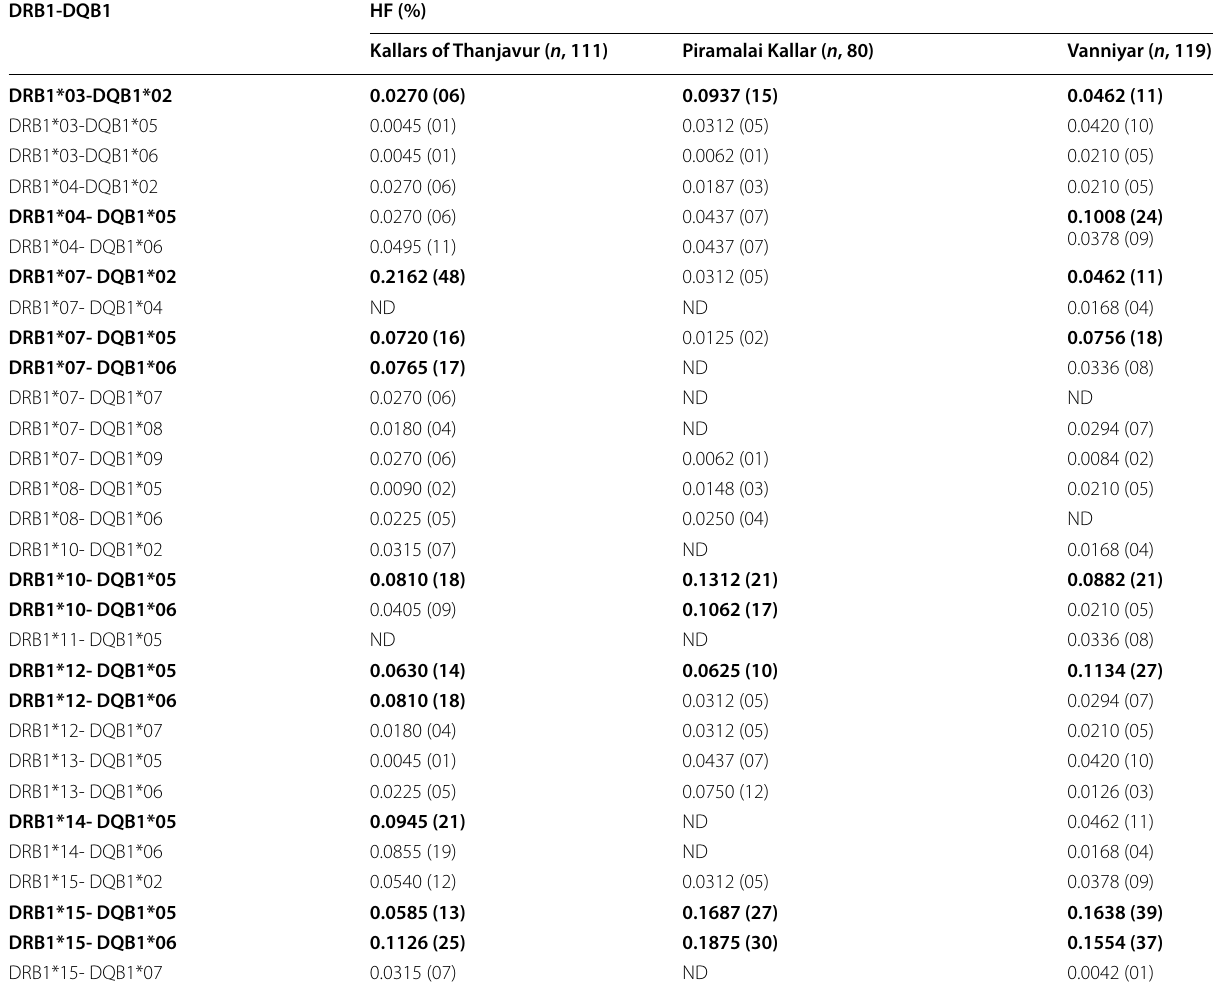
Table 3 Frequencies of HLA-DRB1-DQB1 two-locus haplotypes in selected populations of South